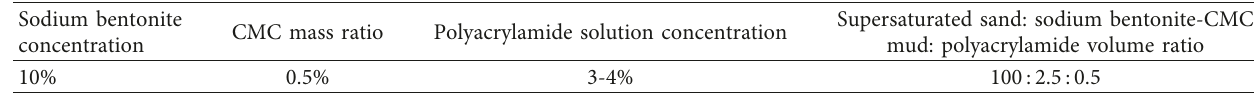
Table 5: Optimal mixing ratio of sodium bentonite-CMC and mud-polyacrylamide solution. Sodium bentonite